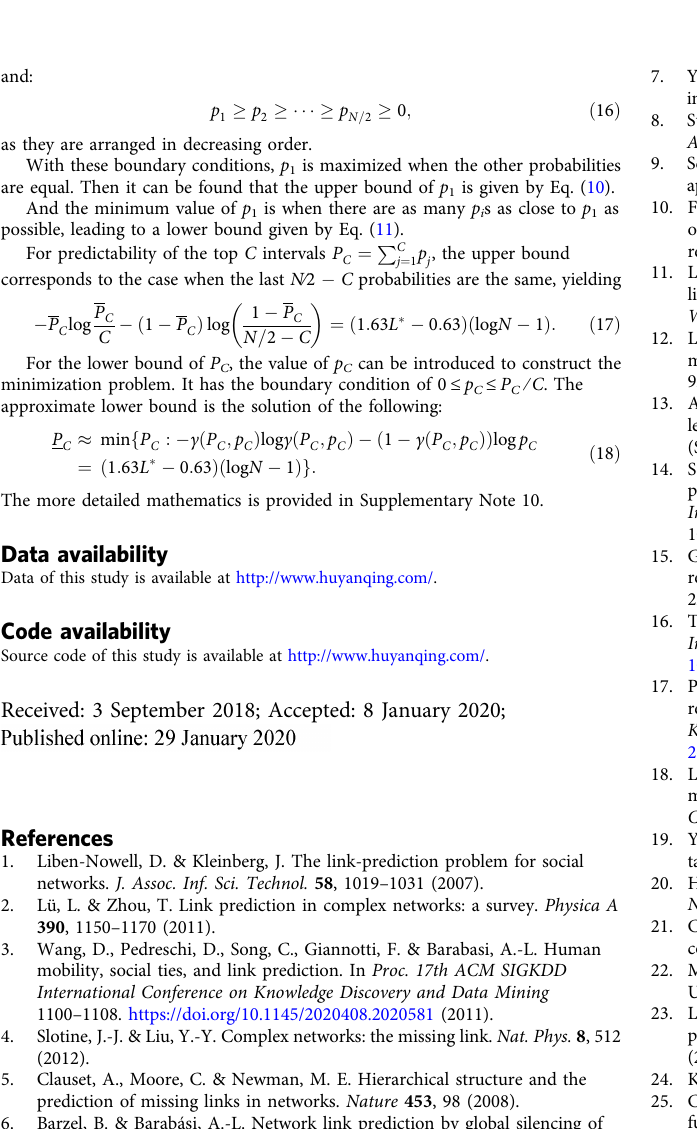
Fig. 5 Effect of regular structures in networks. a A schematic depiction of combining a circle model network (regular) into a real network. In the circle model network, each node has k c links with its closest nodes. b We decrease the regular links by using value of k c from 20 to 2 in the circular model network. Points with the same shape and color correspond to a real network. The arrow presents the fl ow of the value pair ( L (cid:2) ; H (cid:2) clear that our theoretical prediction works better with less regular